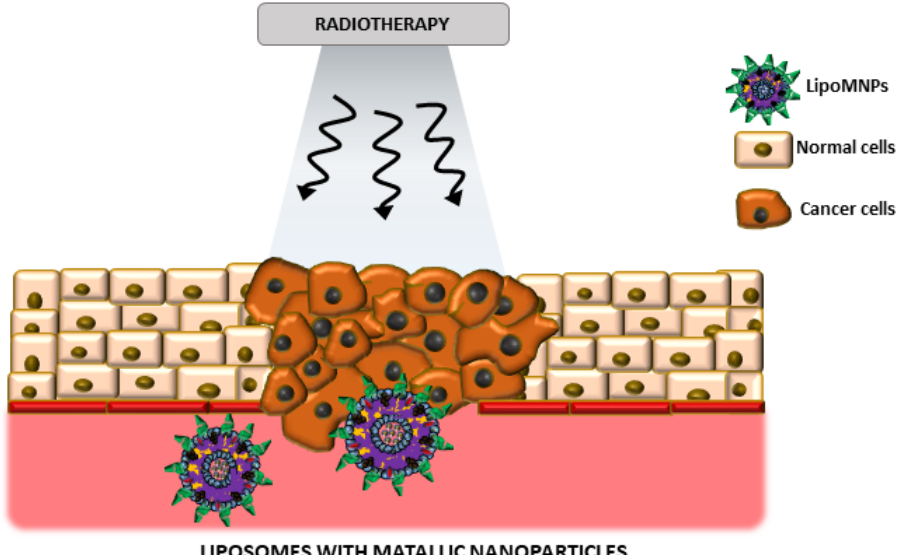
Figure 3. The schematic representation of LipoMNPs (Liposomes with metallic nanoparticles) usage as radiosensitizers in radiotherapy. Arrows are symbols of photons in ionizing radiation during radiotherapy.